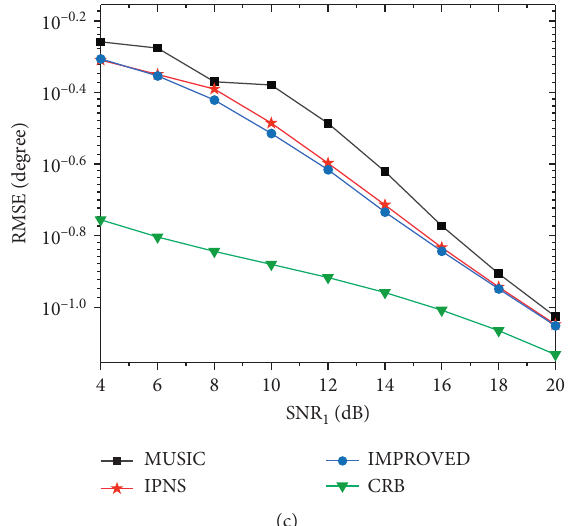
Figure 10: The RMSE of source 1 against SNR